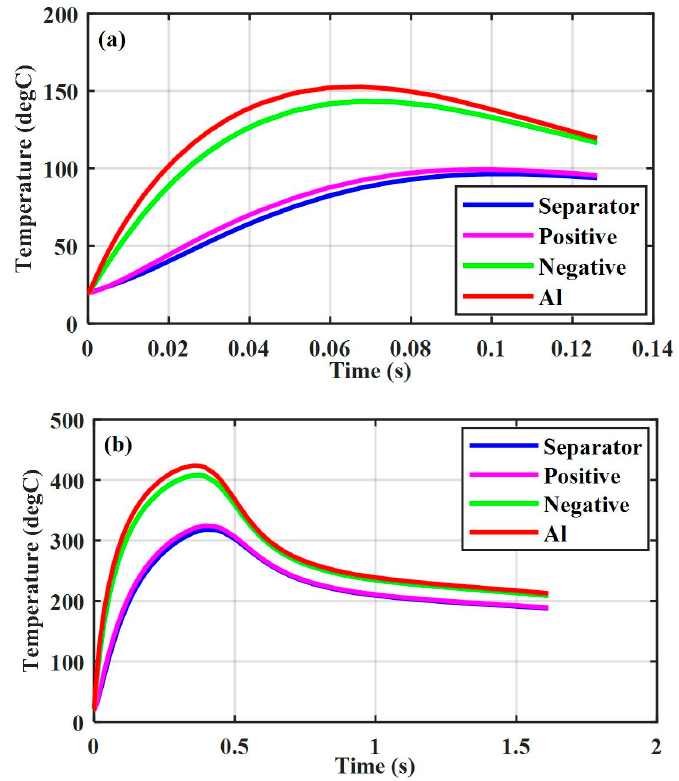
r , aluminum-negative ( a ) SOC = 0.2, and in